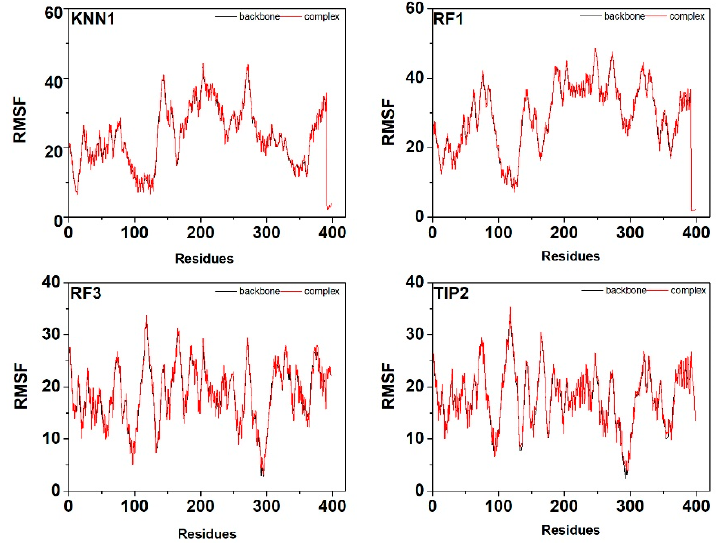
Figure 7. RMSF profiles of the tyrosinase-hdTIPs complexes during 300 ns of the molecular dynamic simulation time.